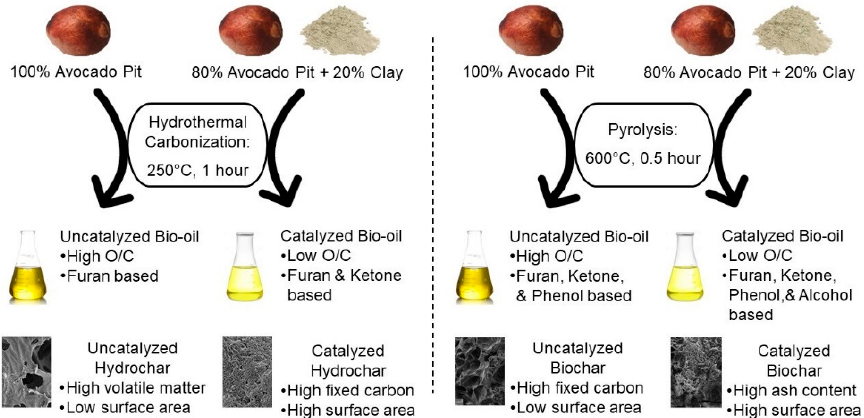
Figure 6. Summary of the thermochemical conversion processes and resulting product characteris- tics .